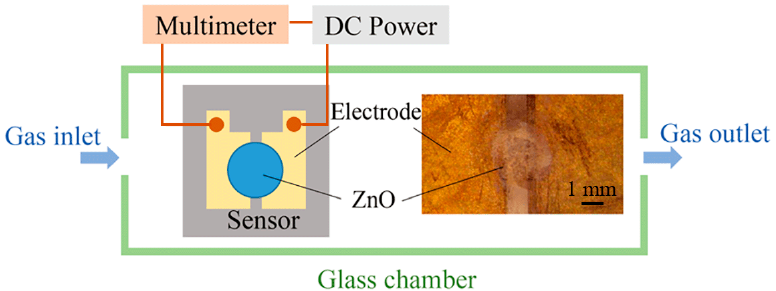
Figure 7. Diagrammatic sketch of the prepared gas sensor and the measuring system. The gap between the two electrodes is about 1 mm. The diameter of ZnO deposition area is in the range of 1.5–2.5 mm.